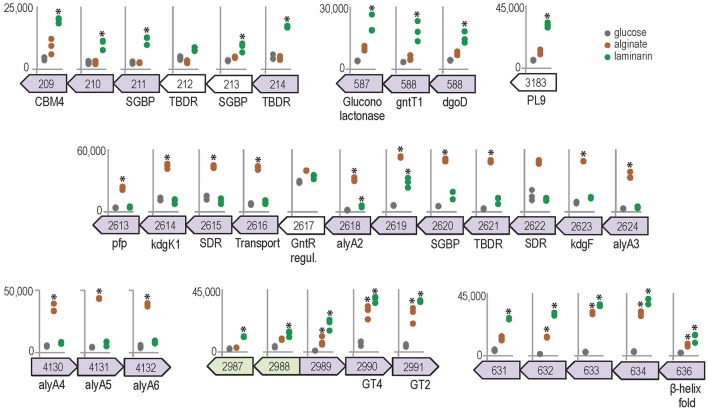
Genomic context and expression values of selected genes induced by alginate (brown) and/or laminarin (green) compared to glucose condition (gray). Asterisks denote significant up-regulation compared to glucose (FWER < 0.05). The y-axis scale reports normalized expression values and is conserved for each genomic region. Genes from the same genomic region and shaded with the same color were found to belong to the same transcription unit by the network approach.